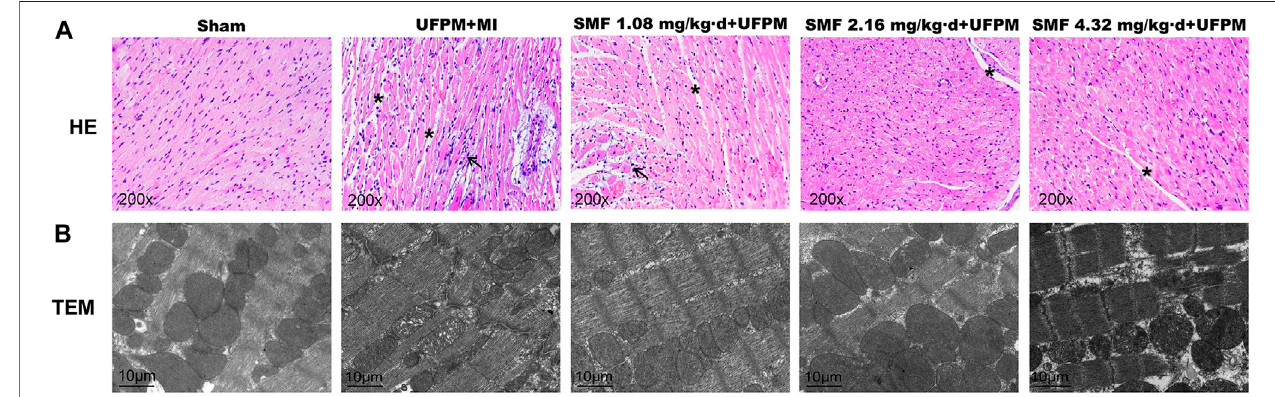
FIGURE 2 | Protective effects of SMF on toxic changes in myocardial tissues in acute UFPM-exposed rats with MI, as shown by hematoxylin and eosin (H&E) stainingandtransmissionelectronmicroscopy(TEM).RepresentativeimagesofH&Estaining( A , × 200)andTEM( B ,bar (cid:2) 10 μ m)inmyocardialtissuesfromtheshamor MI groups pretreated with different SMF concentrations before UFPM exposure. MI, myocardial ischemia; SMF, Shengmai formula; UFPM, ultra fi ne particulate matter.